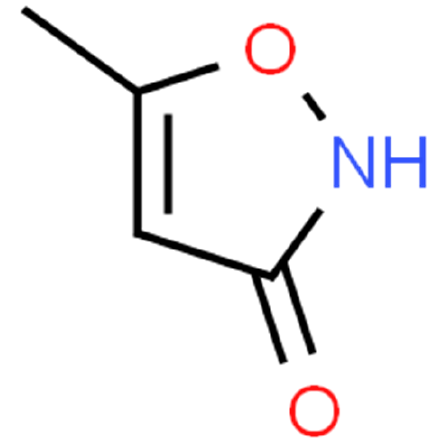
Figure 1. Chemical structure of Hymexazol.